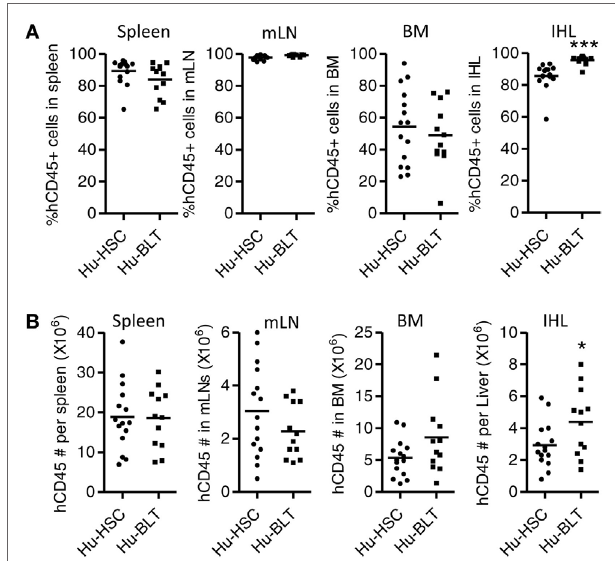
FigUre 2 | Comparison of total human immune cell reconstitution in lymphoid organ of NRG-hu HSC and NRG-hu Thy/HSC mice. NRG-hu HSC and NRG-hu Thy/HSC mice were terminated at 20 weeks after reconstitution and human immune cells in lymphoid organs were detected by flow cytometry. Summarized data show percentage (a) and number (B) of human leukocytes (hCD45 + ) in spleen, mesenteric lymph nodes (mLNs), bone marrow (BM), and intrahepatic leukocytes (IHL) of NRG-hu HSC and NRG-hu Thy/HSC mice. Shown are representative data from n = 15 (NRG-hu HSC) and n = 12 (NRG-hu Thy/HSC) hu-mice per group reconstituted with HSCs ± thymus from same donor. Each dot represents one individual mouse; bars indicate mean (* P < 0.05 and *** P < 0.001, by unpaired, two-tailed Student’s t